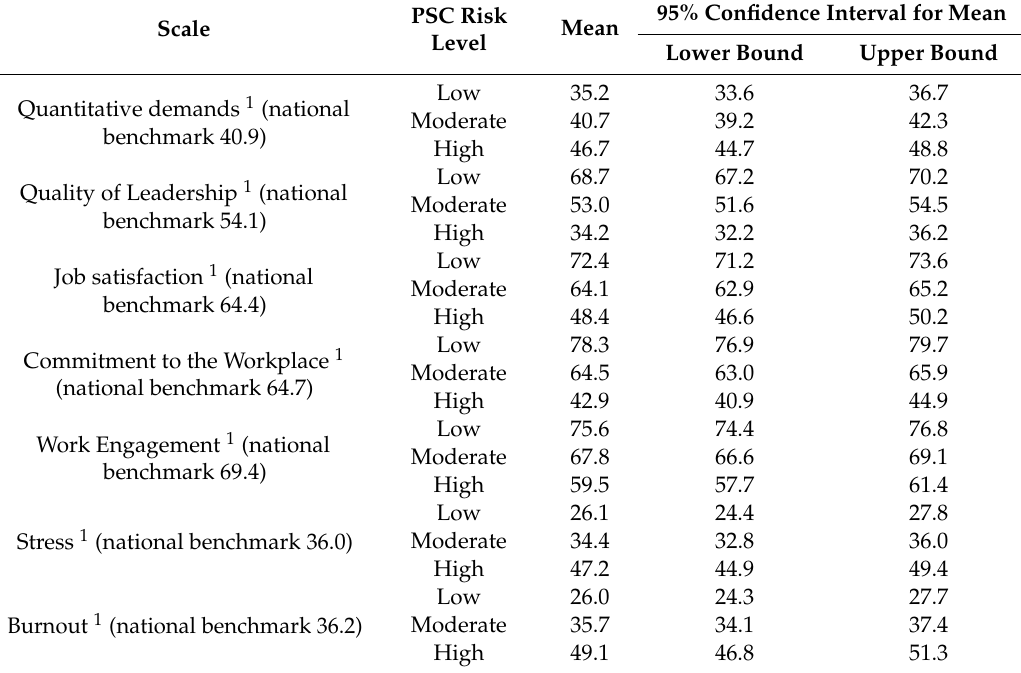
Table 4. For non-managerial employees from the random sample of the Swedish working population ( n = 1882): mean values and the 95% confidence interval for the scales quantitative demands, quality of leadership, job satisfaction, commitment to the workplace, stress, and burnout (range 0–100) depending on PSC risk